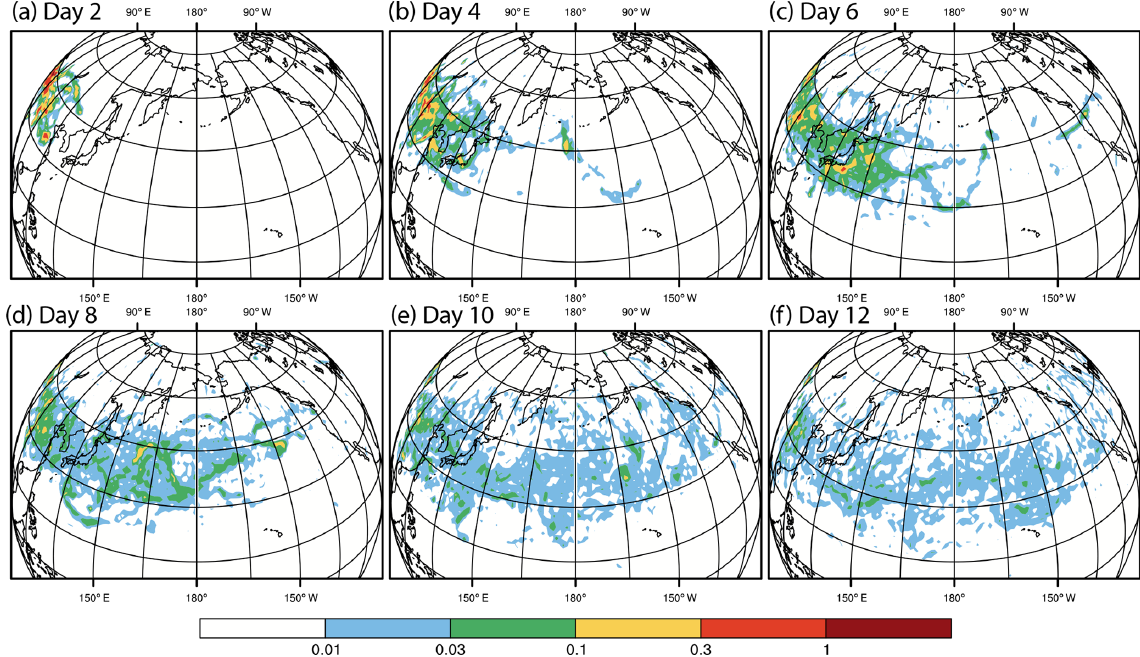
Figure 6. Spatial distribution (%) of trajectory endpoints by the end of days (a) 2, (b) 4, (c) 6, (d) 8, (e) 10, and (f) 12 after emission from the Taklamakan Desert during 2001–2011. The spatial distribution values over all 1 ◦ latitude × 1 ◦ longitude grids in the Northern Hemisphere sum up to 100%.